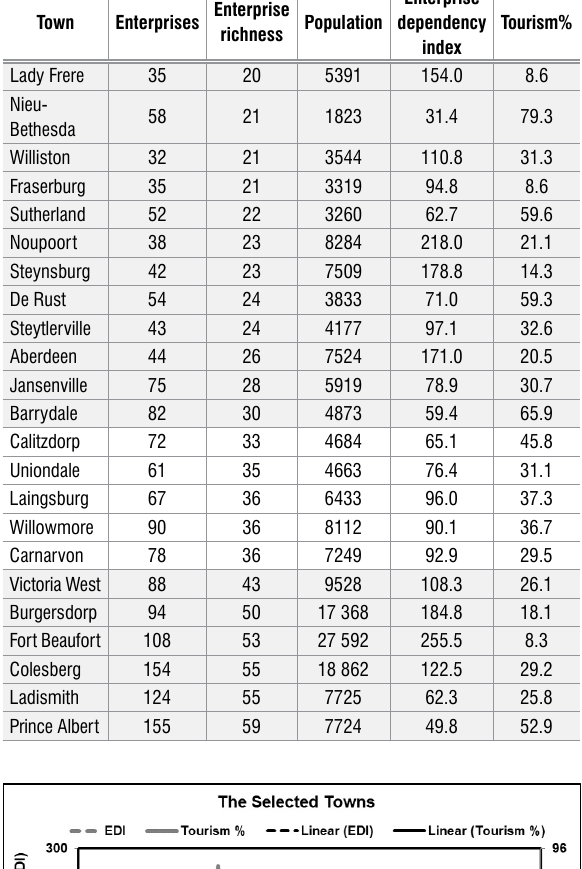
Towns with similar enterprise richness values. Tourism% indicates the share of the enterprises of the tourism and hospitality sector of the total enterprises in the towns.